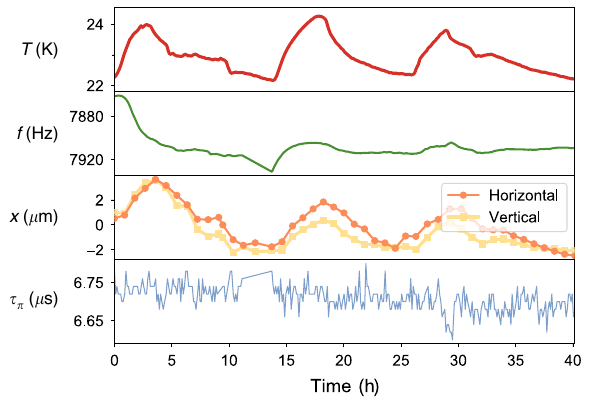
Fig. 4 Ancillary measurements in the stabilized GST experiment. The microwave drive frequency f , the horizontal and vertical detection beam offsets x , and microwave π -pulse time τ π were periodically recalibrated and tracked over the course of the experiment. The Spearman correlation coef fi cient ( ρ ) con fi rms that the ambient temperature T is well correlated with the drive frequency ( ρ = 0.64) and the horizontal and vertical beam offsets ( ρ = 0.86 and ρ = 0.84), but it is not well correlated with the π -pulse time ( ρ =